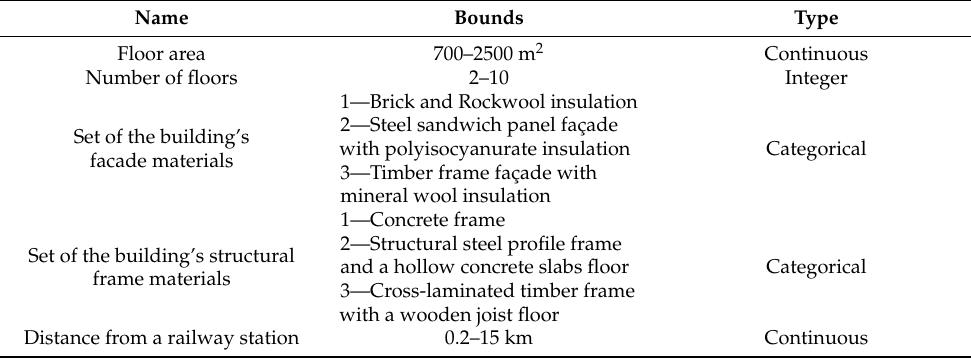
Table 2. Design variables used in the demonstrator